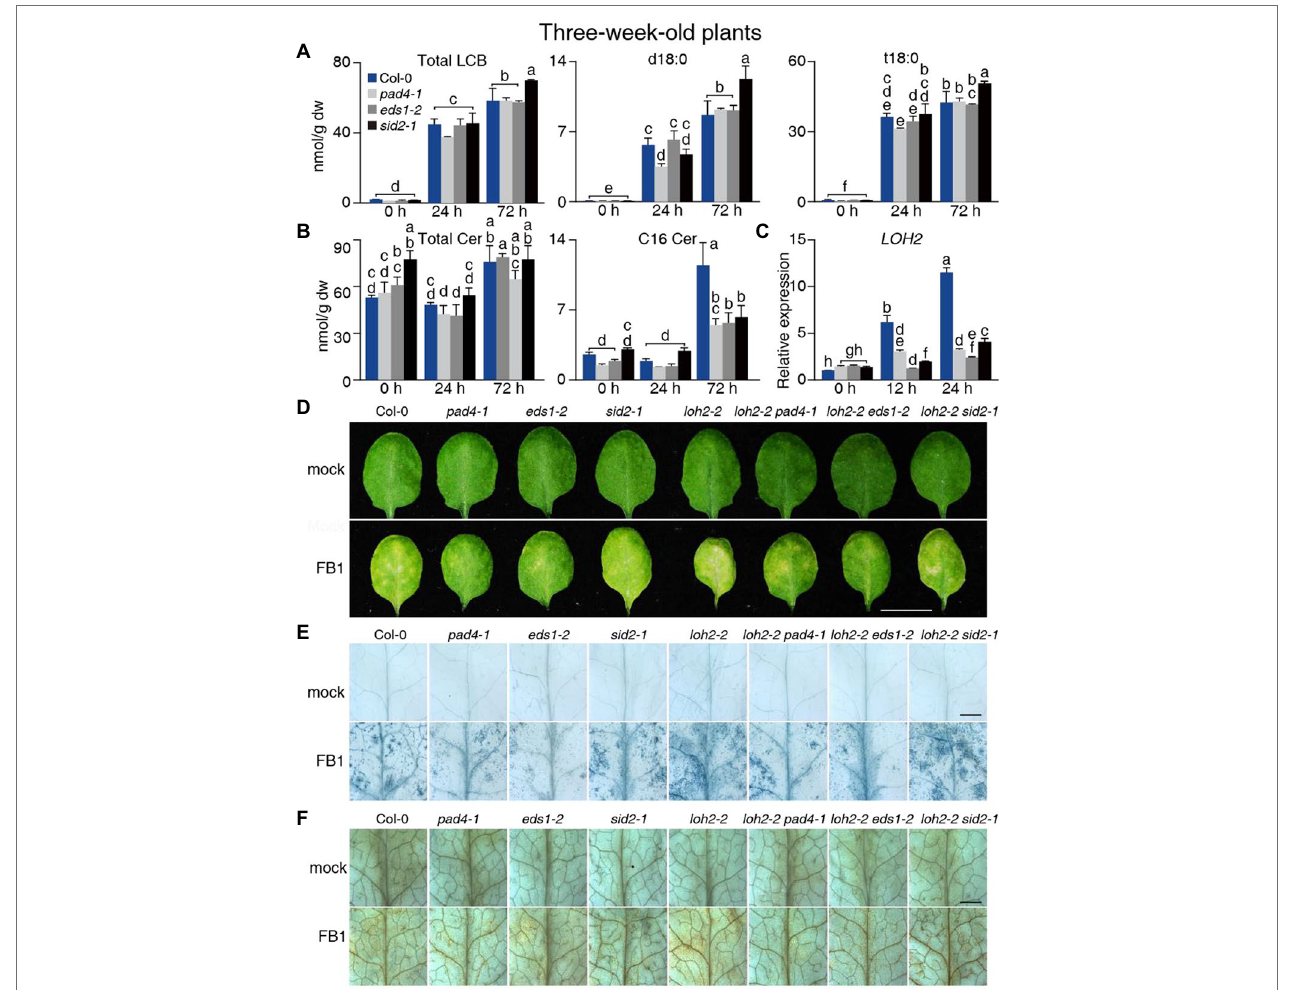
FIGURE 3 | Sphingolipid profile of 3-week-old Col-0, pad4-1- , eds1-2- , and sid2-1 -plants upon FB1 treatment. (A) Total contents of LCB, d18:0, and t18:0. (B) Total contents of Cer and C16 Cer. (C) Relative LOH2 transcript levels in plants before (0 h), 12 or 24 h post 10 μ M FB1 treatment. ACT2 served as the internal control. Values were normalized to Col-0 levels (set to 1). (D) The phenotype of plants 2 days post-FB1 treatment. Bar = 1 cm. (E) Trypan blue staining of leaves from (D) . Bar = 1 mm. (F) DAB staining of leaves from (D) . Bar = 1 mm. Values are means ± SE from triplicate biological repeats in (A–C) . Different letters indicate significant differences between all genotypes/time points, as determined by Fisher’s PLSD ( p < 0.05). At least 30 plants per line were tested each time in (D) and at least 12 leaves per line were stained each time in (E,F) . The experiments were repeated three times using independent